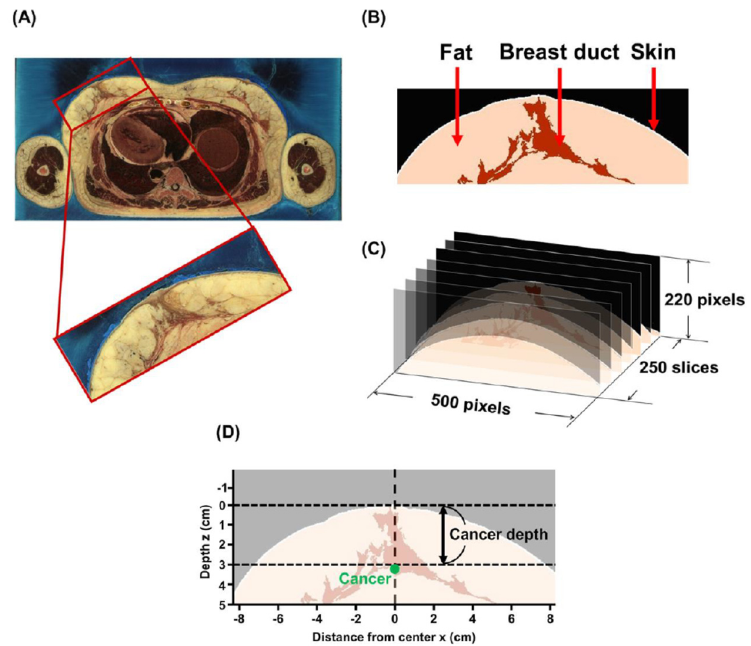
Figure 2. Implementation of the contour and the internal structures derived from breast anatomical data of the Visible Human Project (VHP). ( A ) Cropped image from a slice. ( B ) Allocation of the fat, the duct and the skin based on pixel value. ( C ) Reconstruction of a 3-D voxel model. ( D ) Setting of coordinate system in the slice containing the center and top of nipple ( x = 0, z = 0). The depth denotes the distance from z = 0 to the upper surface of the cancer. Table 1. Optical parameters specific to tissues in the visible (VIS), the near-infrared (NIR), and the shortwave-infrared